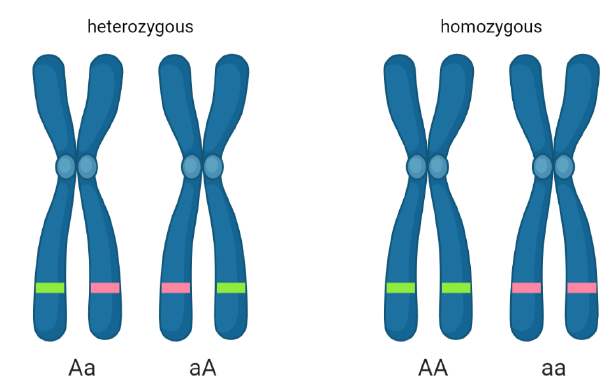
Figure 2. Difference between heterozygous and homozygous alleles.